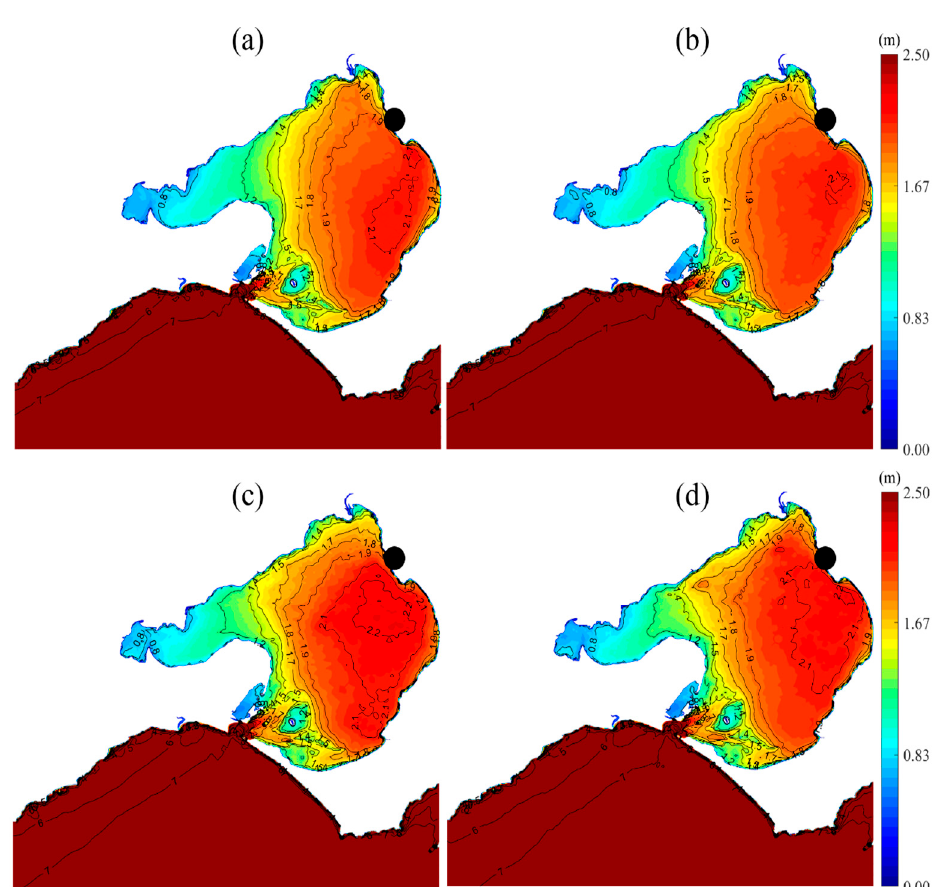
Figure 13. Estimates of the 100-year return SWHs based on different threshold levels: the 90th ( a ), 95th ( b ), 99th ( c ) and 99.5th ( d ) percentiles using POT approach.